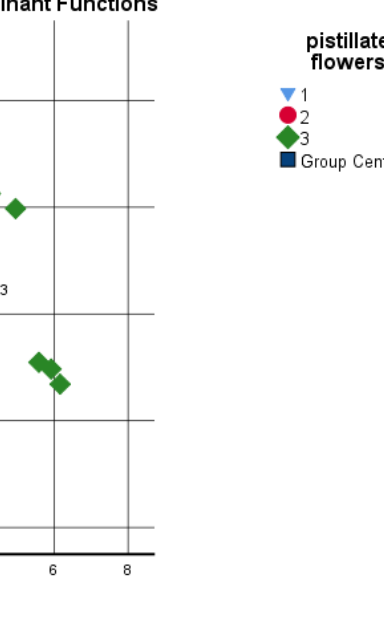
Figure 6. Discriminant analysis by pistillate flowers’ receptivity time as a grouping variable; 1-early: 118–119 days; 2-medium: 128 days; late: 133–135 days (independents: sum of flavonoids and naphthoquinones, as well as juglone concentration).